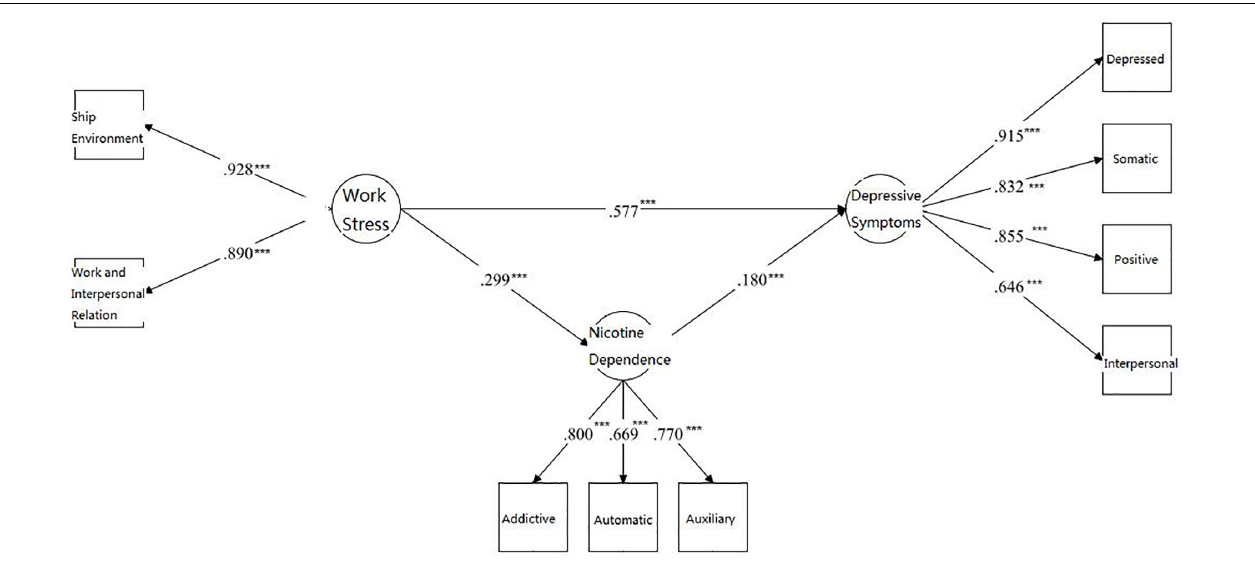
FIGURE 1 | Path analysis describing the associations between work stress, depressive symptoms, and nicotine dependence among fishermen with a smoking habit. ∗∗∗ p <